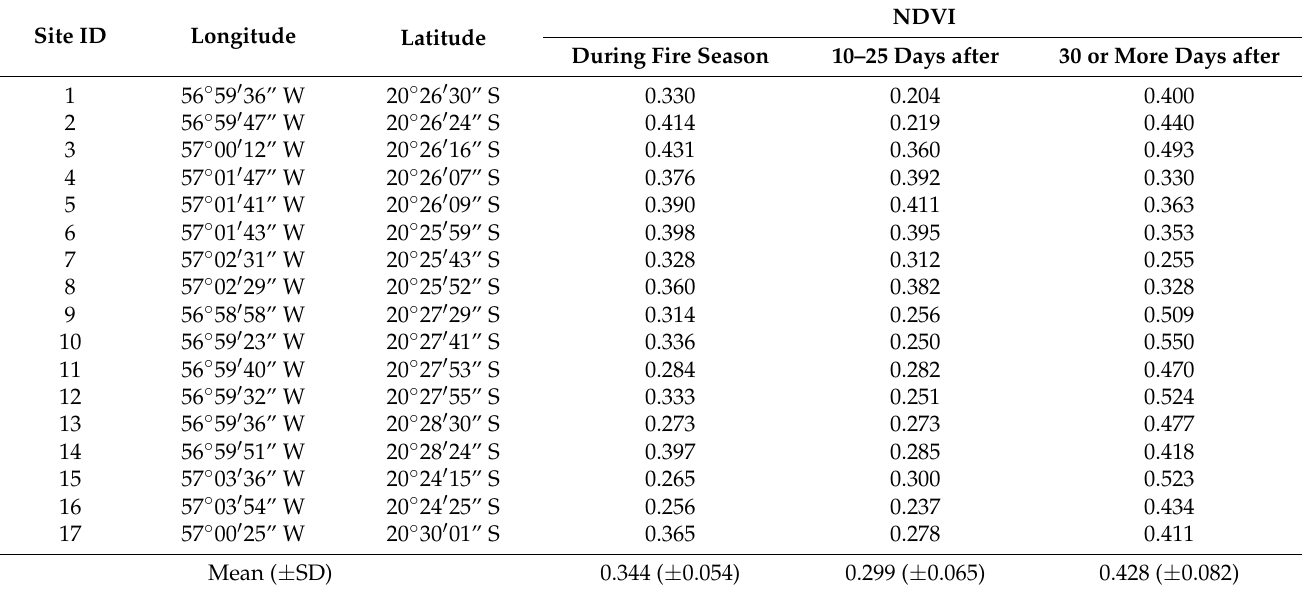
Table 1. Study site locations and Normalized Difference Vegetation Index (NDVI) Values during, 10–25 after, and 30 or more days after